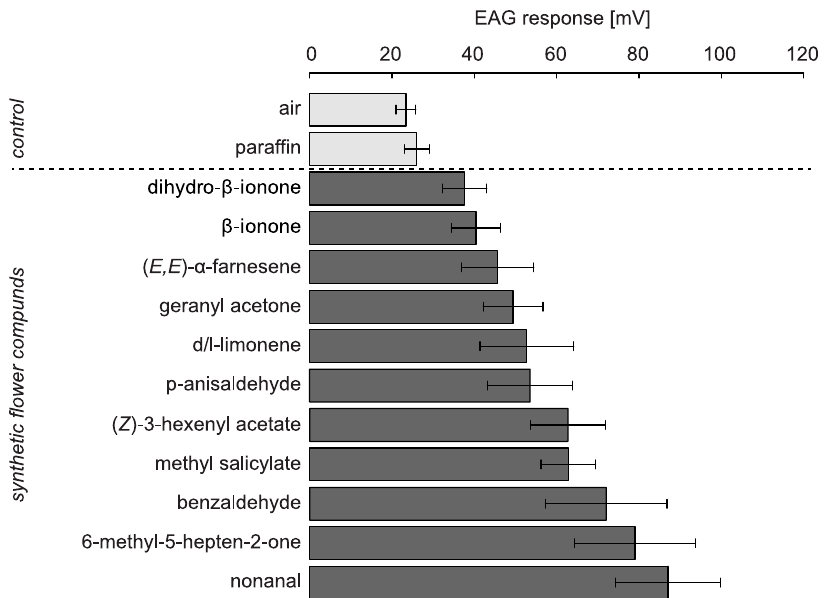
Figure 2. Antennal responses of naı¨ve O.bicornis females to synthetic compounds. Compounds were identified from flower volatile extracts of strawberry varieties (10 2 3 dilution; mean 6 SE, n=10). p , 0.05=significant.